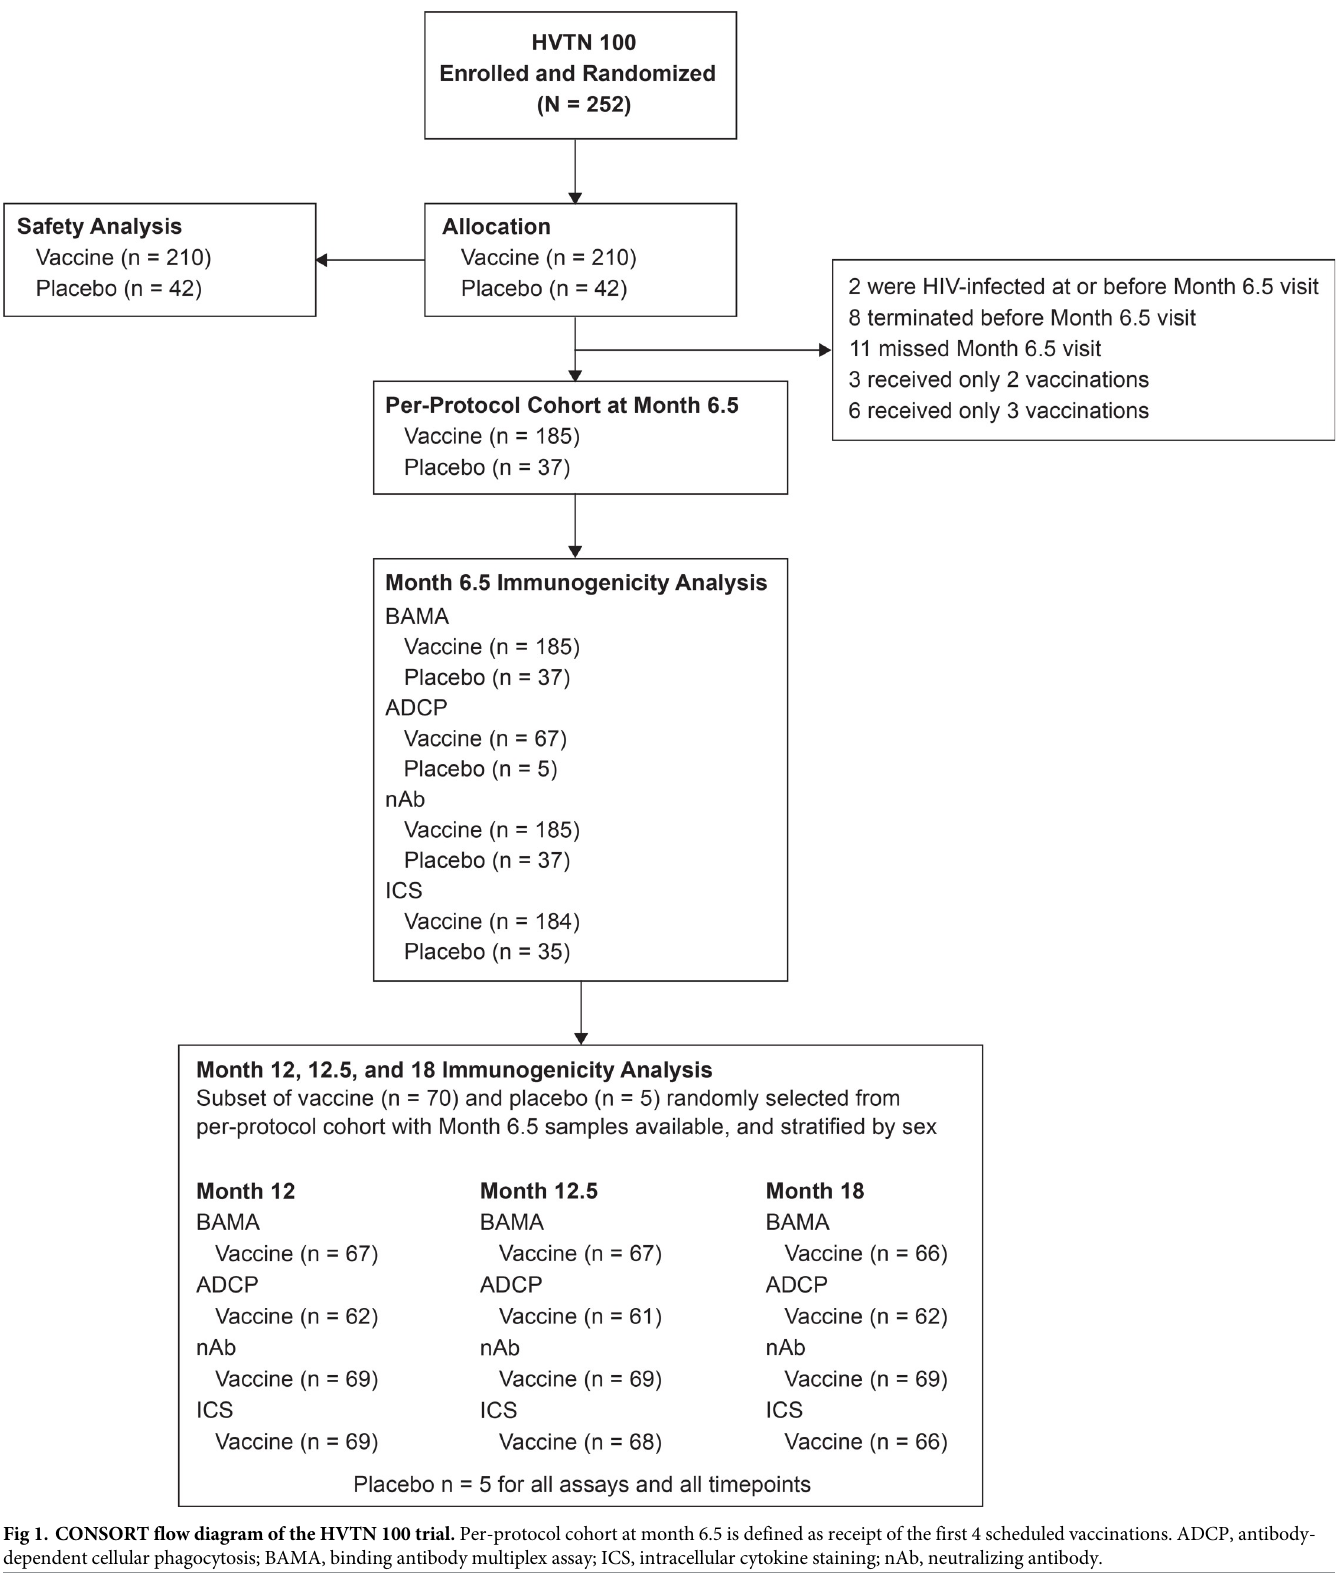
Fig 1. CONSORT flow diagram of the HVTN 100 trial. Per-protocol cohort at month 6.5 is defined as receipt of the first 4 scheduled vaccinations. ADCP, antibody- dependent cellular phagocytosis; BAMA, binding antibody multiplex assay; ICS, intracellular cytokine staining; nAb, neutralizing antibody.